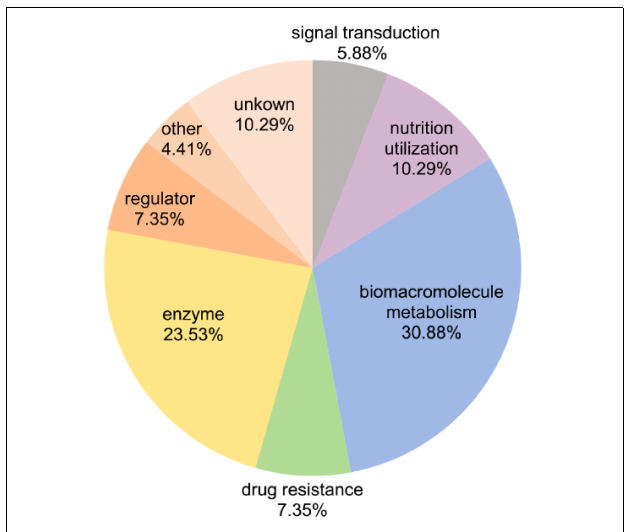
FIGURE 7 | Functional classification of 65 key FGPs with significantly altered fucosylation